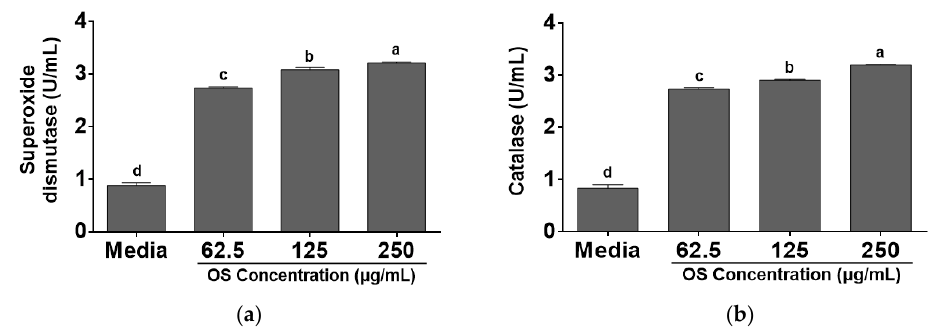
Figure 3. Antioxidant enzymes activities of A. cepa skin (OS) extracts in RAW 264.7 cells. ( a ) Superoxide dismutase activity (SOD); ( b ) catalase activity (CAT). Data was expressed as the mean ± SEM. a–d Different letters on bars are significantly different among SOD or CAT values at different concentrations ( p < 0.05).